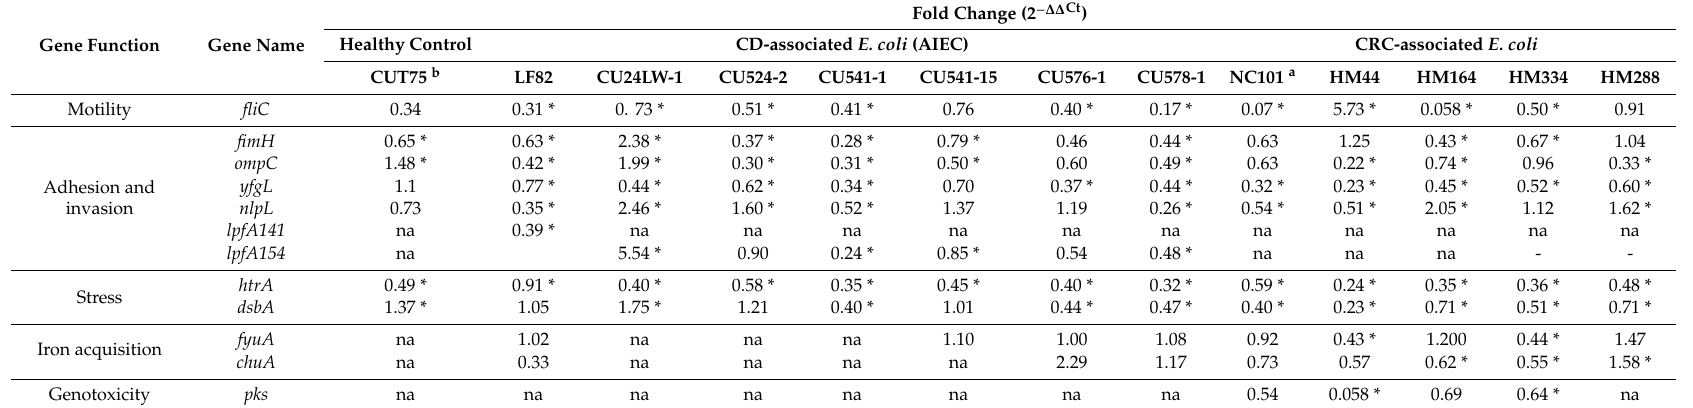
Table 3. SCFA regulates virulence gene transcription in E.